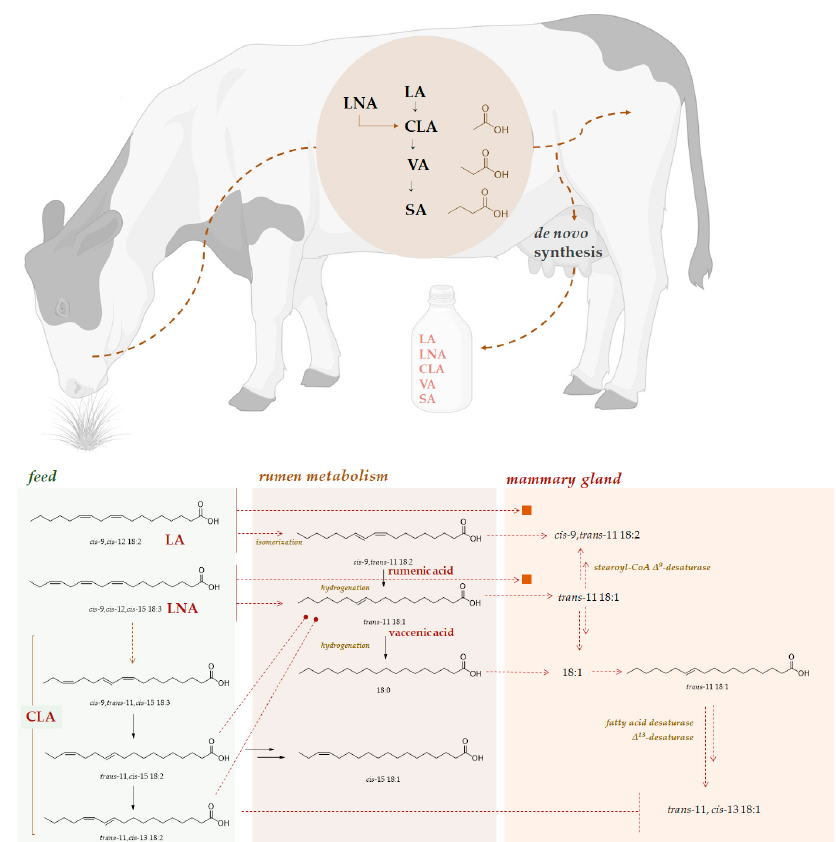
Figure 7. Schematic ruminal biohydrogenation process of free unsaturated fatty acids in rumen and milk fat profile influenced by de novo synthesis in the mammary gland and by mobilization of adipose tissue. Figure created with BioRender.com. LNA, linolenic acid; LA, linoleic acid; CLA, conjugated linoleic acid; VA, vaccenic acid; SA, stearic acid.